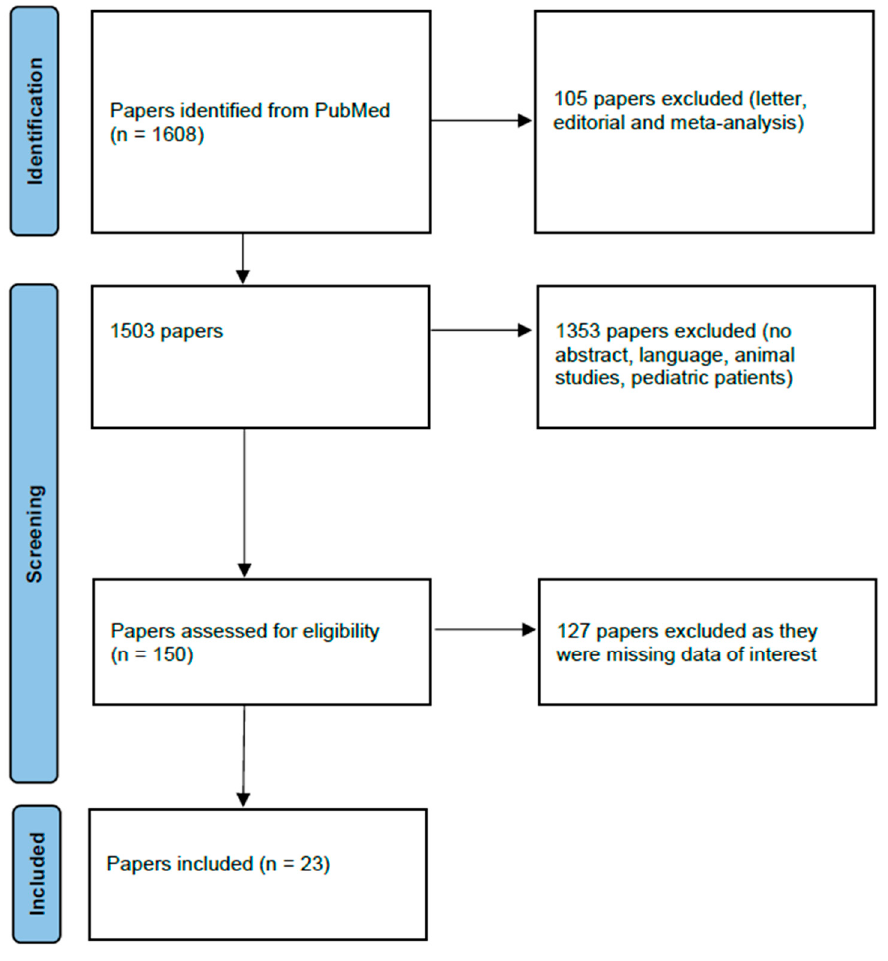
Figure 2. PRISMA 2020 fl ow diagram. This diagram illustrates the process followed for the collec- tion and selection of papers used in our